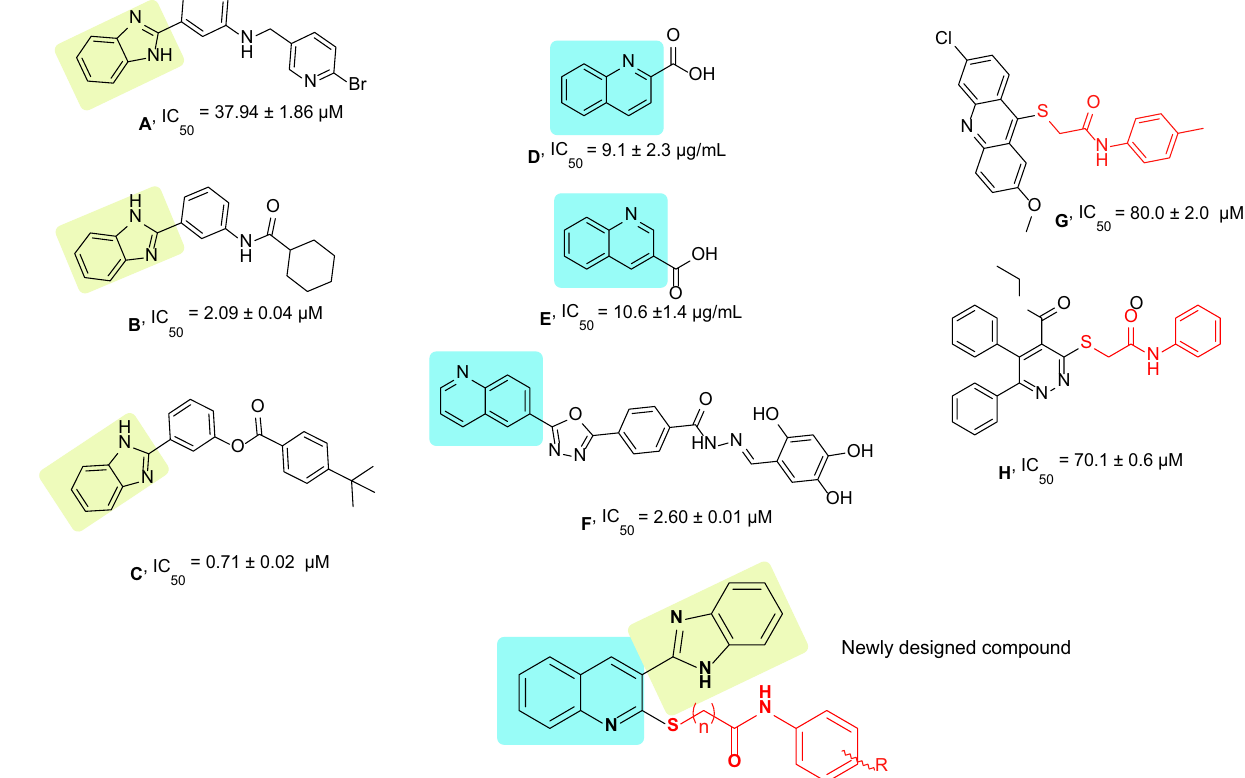
Figure 1. Schematic illustration of previously reported α-glucosidase inhibitors and newly designed